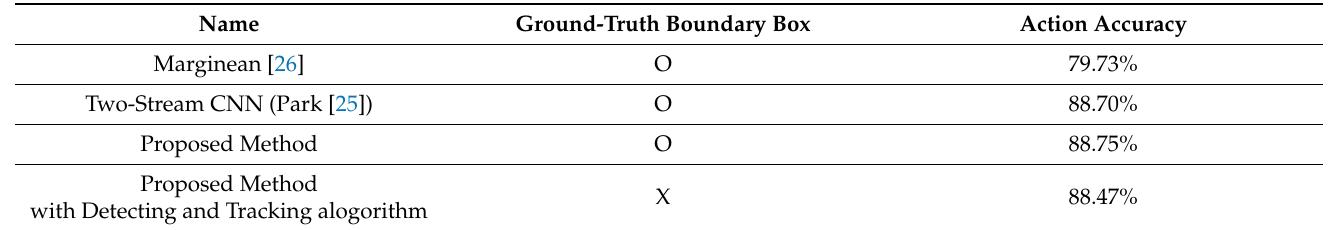
Table 10. Comparison of pedestrian-action recognition for state-of-the-art in single-task learning algorithm with the JAAD testing